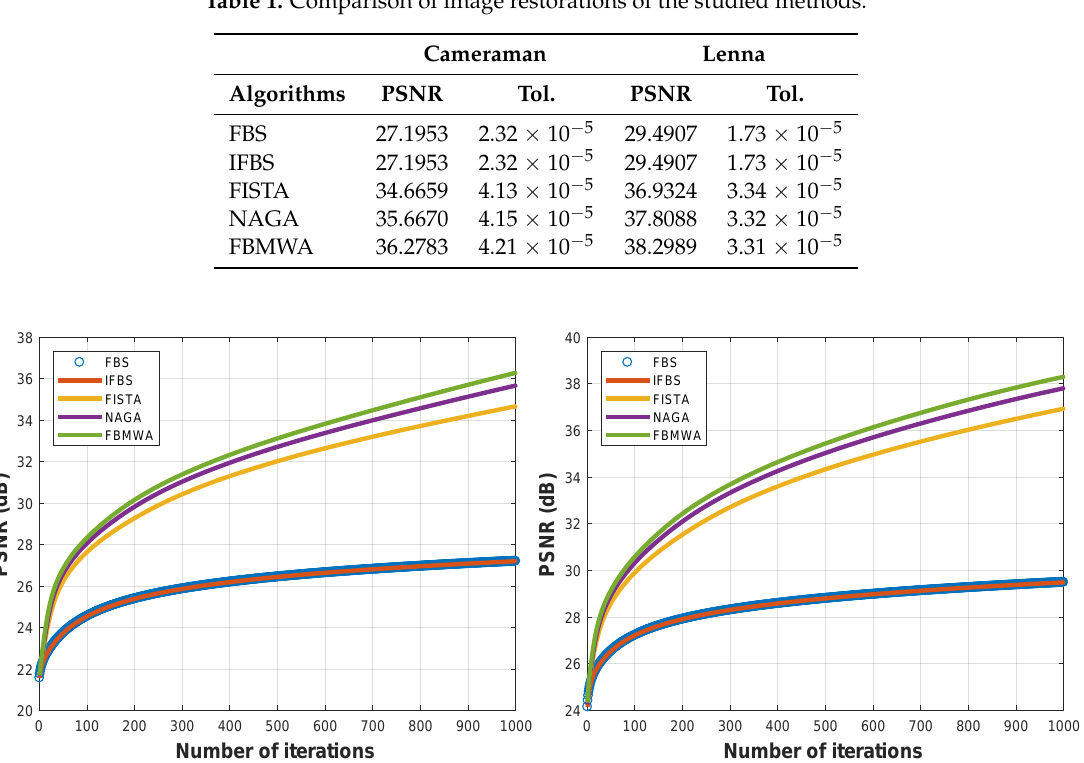
Figure 1. The graphs of peak signal-to-noise ratio (PSNR) for Cameraman ( left ) and Lenna ( right